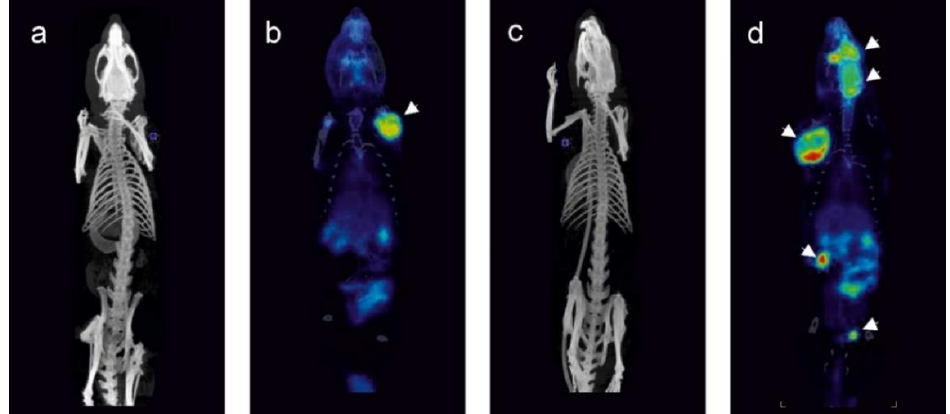
Figure 3. Representative FDG PET images ( b,d ) with reference CT scans ( a,c ) of tumor-bearing homo- zygous Tp53 knockout rats. Panels a and b illustrate a single tumor localized on the forelimb of the rat. Panels c and d illustrate a rat bearing several tumors: within the head, on the forelimb and within the abdomen. Tumors on PET images are indicated by arrows.